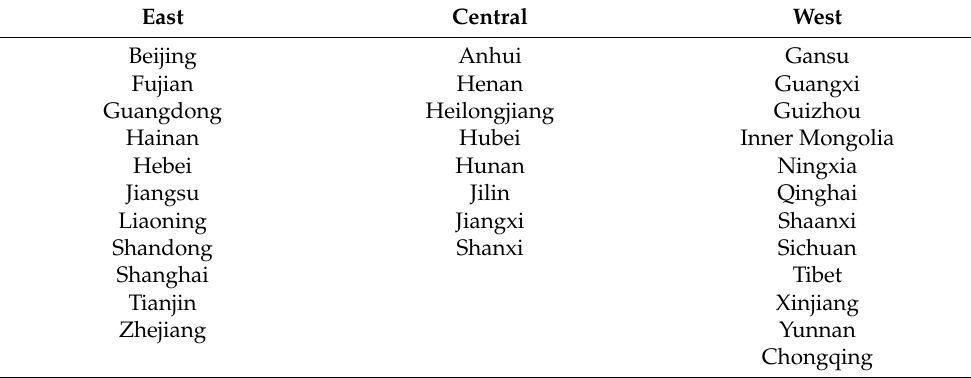
Table A1. Regional distribution in China.